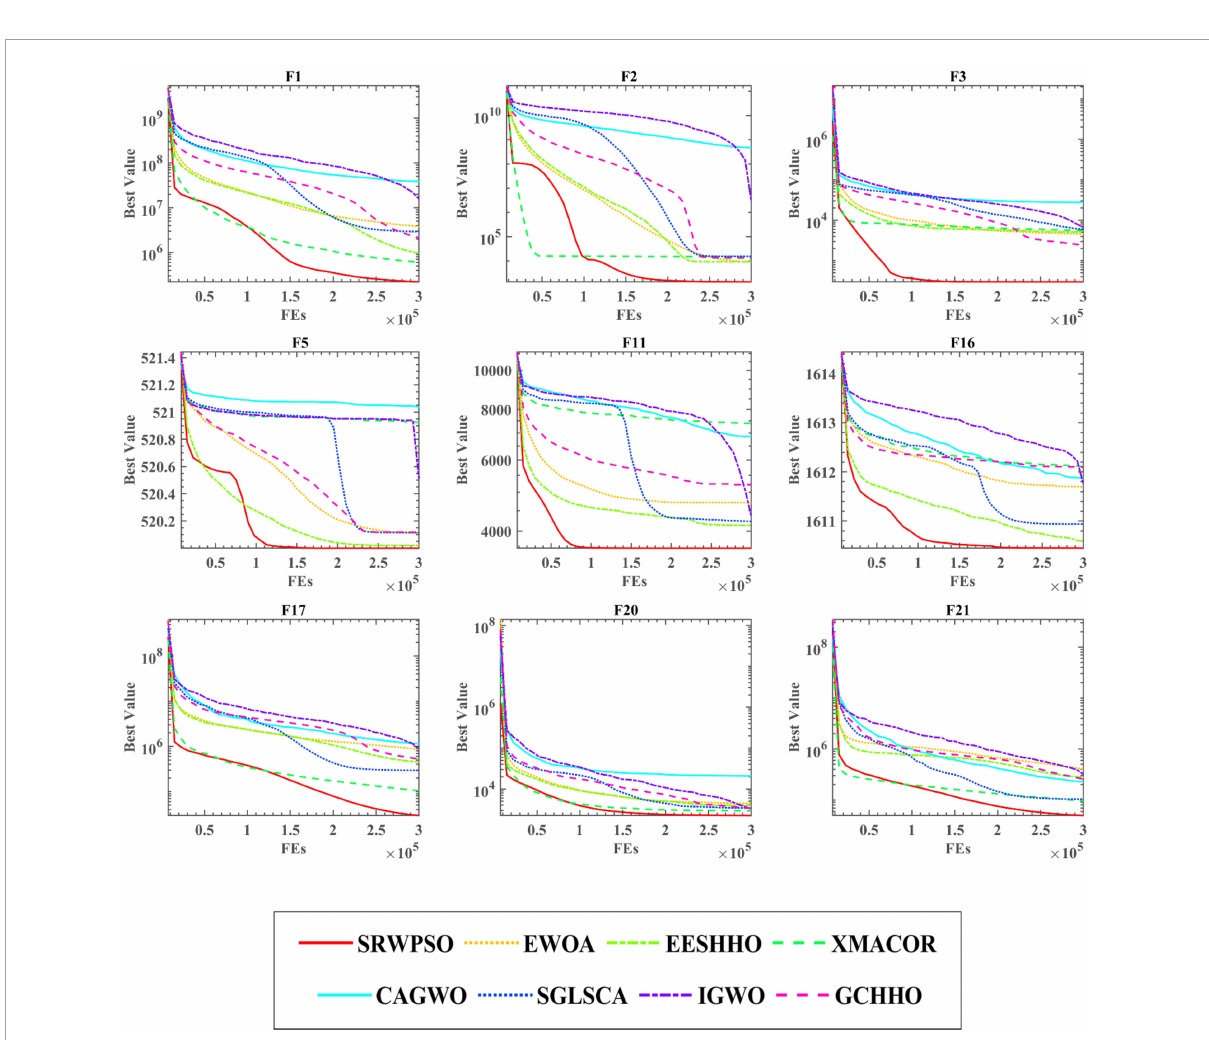
FIGURE14 The convergence curves of SRWPSO and new peer